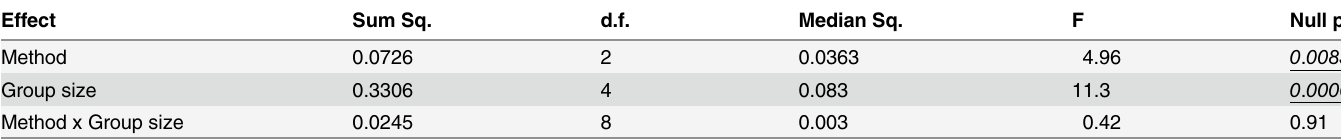
Table 3. Impact of time course aggregation into subject groups.